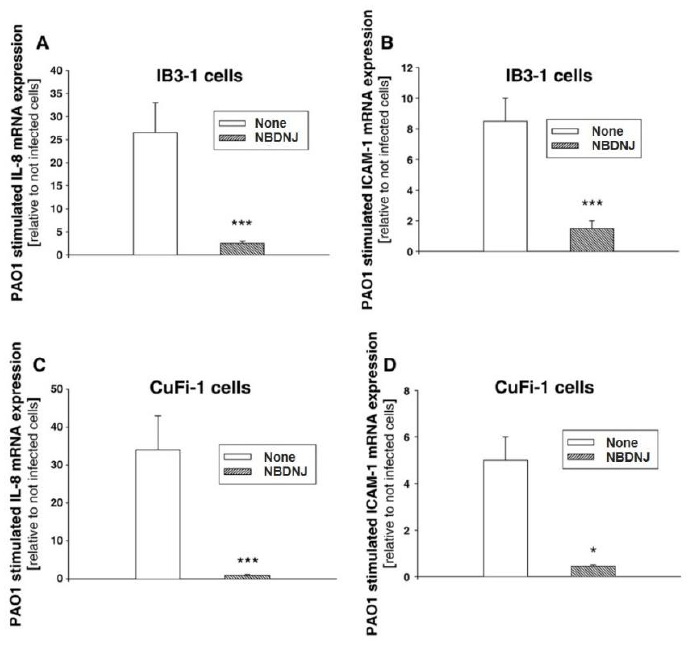
Figure 18. Effect of NBDNJ on the P. aeruginosa stimulated IL-8 and ICAM-1 mRNA expression in ( A , B ) IB3-1 cells and ( C , D ) CuFi-1 cells. Cells were incubated for 24 h in the presence of NBDNJ (200 μM) and infected with PAO1 (50 CFU/cell) for 4 h. * p < 0.05; *** p < 0.001. This figure was reprinted from [78], with permission from Elsevier.